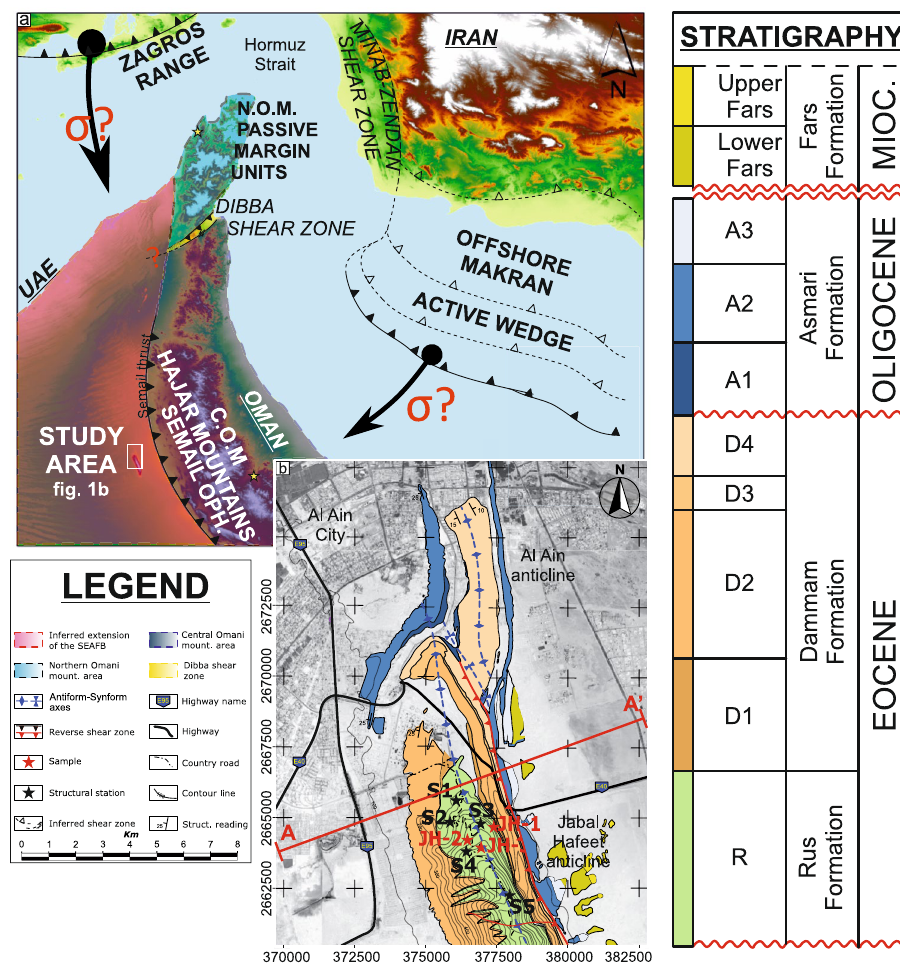
Figure 1. ( a ) Digital Elevation Model (based on SRTM satellite images, created in ArcMAP 10.6.1, ESRI Spatial Analyst) of the area between Iran, Oman, United Arab Emirates with a schematic representation of the major tectonic lineaments (adapted from 2,3 ) and geological domains (adapted from 2,16 ) in the region. Yellow stars indicate the location of the carbonate U–Pb ages from 6,7 . ( b ) Schematic geological map of the Cenozoic units outcropping in the Jabal Hafeet anticline near the city of Al Ain, showing the location of the structural measurement stations and the sample collection sites. Base-map consists of a Landsat 8 satellite photo of the area using the WGS84 geodetic